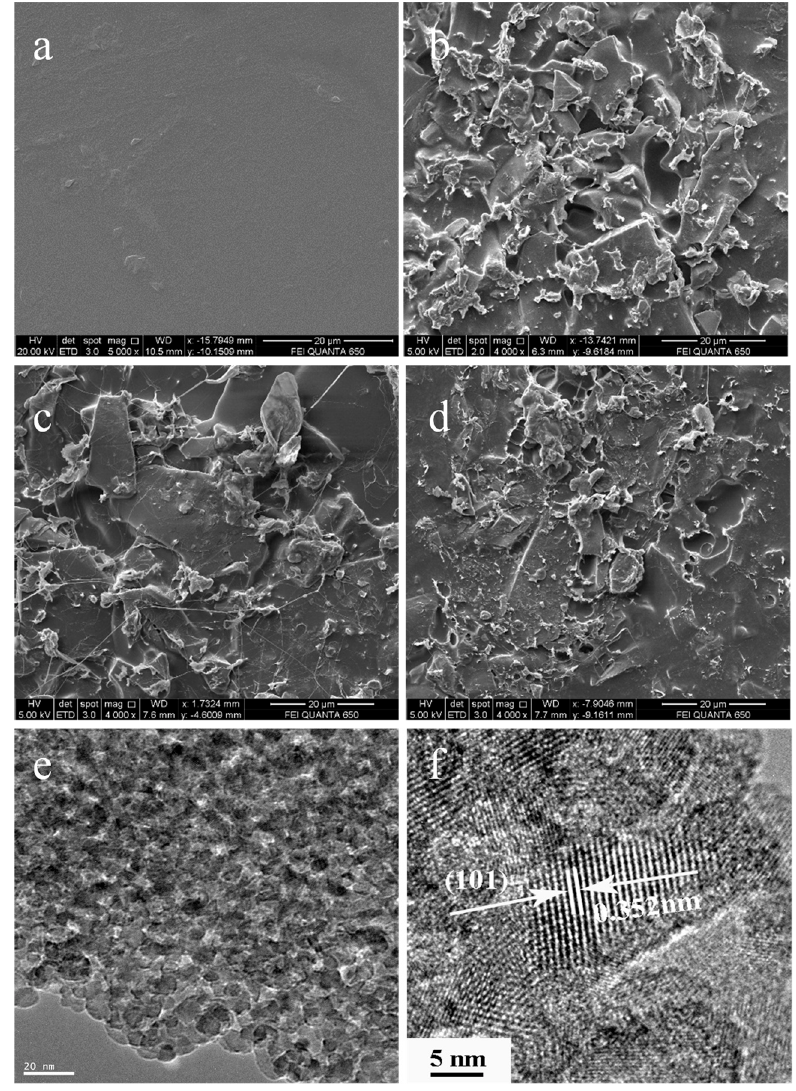
Figure 1. SEM images of the surfaces of ( a ) pure PVA, ( b ) 8 wt%-0-PVA/NCD-TiO 2 , ( c ) 8 wt%-120- PVA/NCD-TiO 2 , and ( d ) 8 wt%-160-PVA/NCD-TiO 2 ; TEM images of ( e , f ) the NCD-TiO 2 nanoparti- cle.